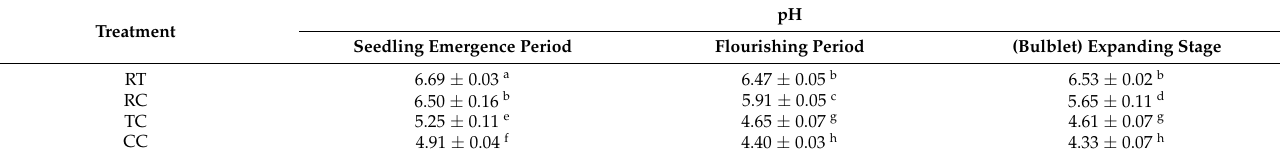
Table 1. The pH values in three growth stages of L. brownii